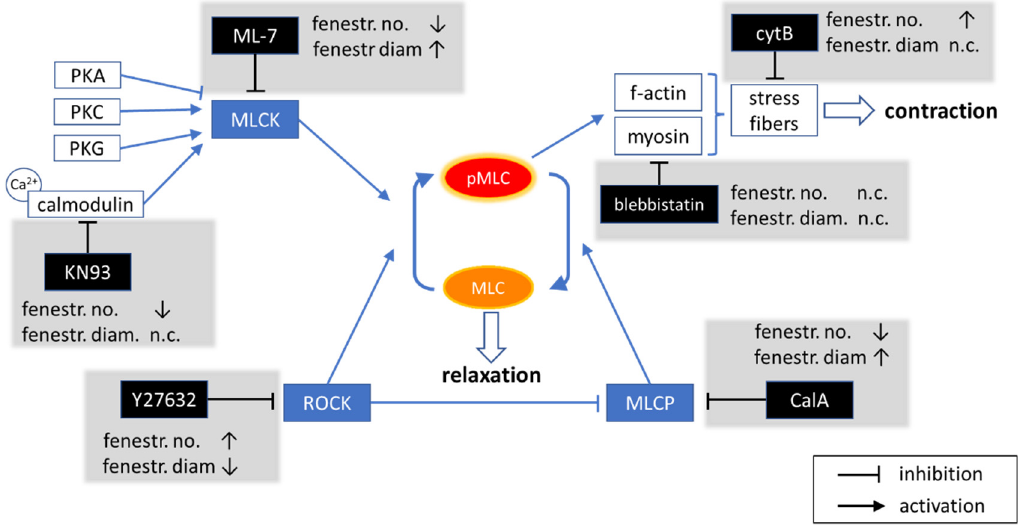
Figure 7. A diagram showing the effect of selected inhibitors on the regulation of MLC phosphory- lation and the observed effect on fenestrations in LSEC. n.c.—no change, ↓ —fenestration number (fenestr. no.)/diameter (fenestr. diam.) decrease, ↑ —fenestration number/diameter increase.